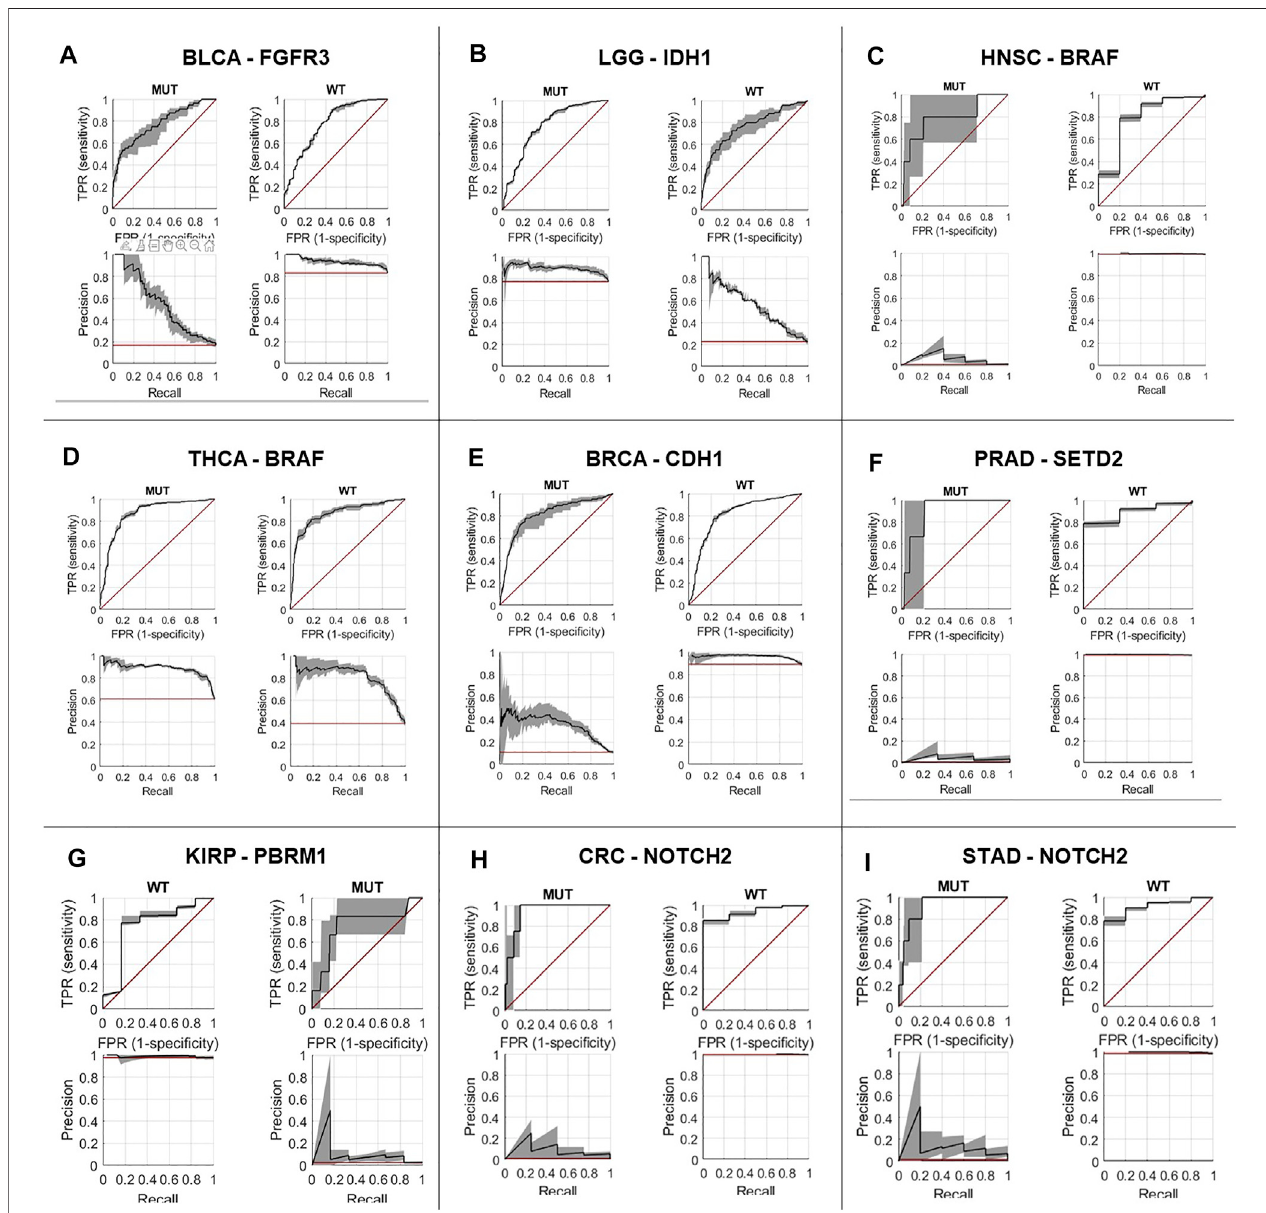
FIGURE 4 | Prediction performance for single gene alterations, representative genes in nine tumor types. Receiver operating curve for: (A) FGFR3 alterations in bladdercancer(BLCA), (B) IDH1 alterations inlowgradeglioma(LGG), (C) BRAF alterations inheadandnecksquamouscellcarcinoma(HNSC), (D) BRAF alterationsin thyroidcarcinoma(THCA), (E) CDH1 alterationsininvasivebreastcarcinoma(BRCA), (F) SETD2 alterationsinprostateadenocarcinoma(PRAD), (G) PBRM1 alterations in renal cell carcinoma (KIRP), (H) NOTCH2 alterations in colorectal adenocarcinoma (CRC), (I) NOTCH2 alterations in stomach adenocarcinoma (STAD), MUT: mutated, WT: wild